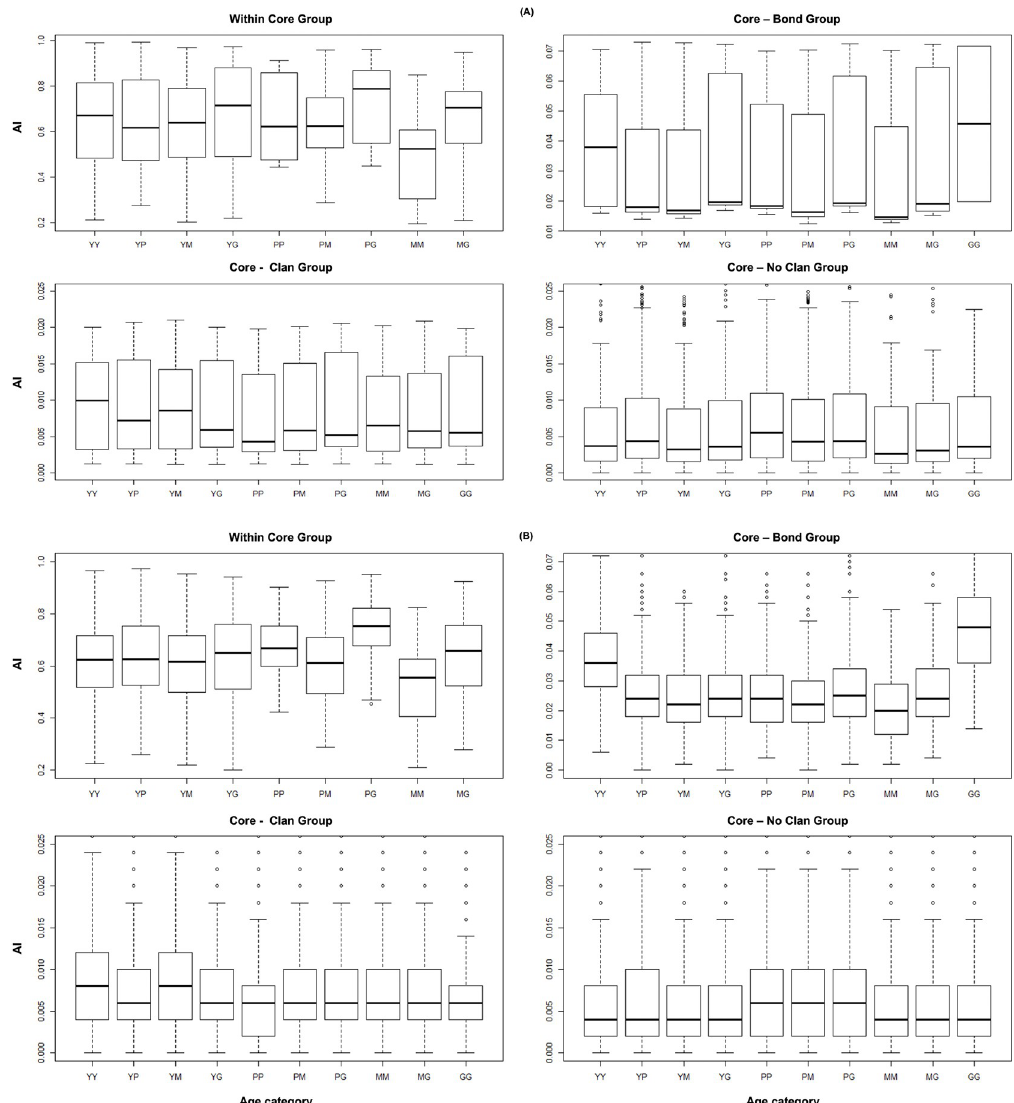
Fig 1. The distribution of association indices in (A) the empirically based versus (B) virtual populations, as a function of age category and kinship of the associating individuals. Age categories are abbreviated using the following symbols: Y—young adult; P—prime adult; M—mature adult; G–the matriarch. During each random deletion, the same proportion of individuals as in targeted deletions was removed randomly. After every deletion proportion, we recalculated the following network level indices: clustering coefficient, as well as weighted diameter, global efficiency and modularity (Table 1). As in the empirically based portion of our study, we used the Hedge’s g test to quantify the difference in the effect size between the means of all network indices across 1) the deletion proportion spectrum, 2) deletion type and 3) deletion metric [96].